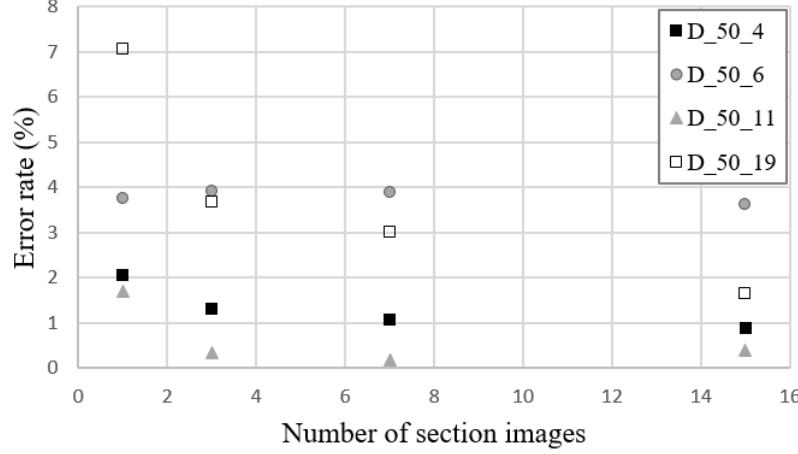
Figure 11. Error of the re-estimated crack width to the actual crack width as more images were applied for the calculation of average crack depth.